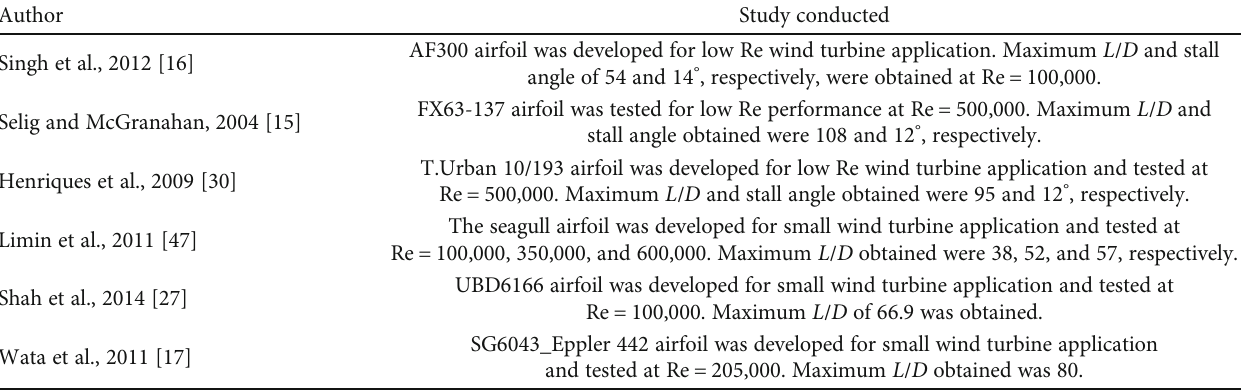
Figure 8: Airfoil performance comparisons [28]. Table 2: Airfoil performance